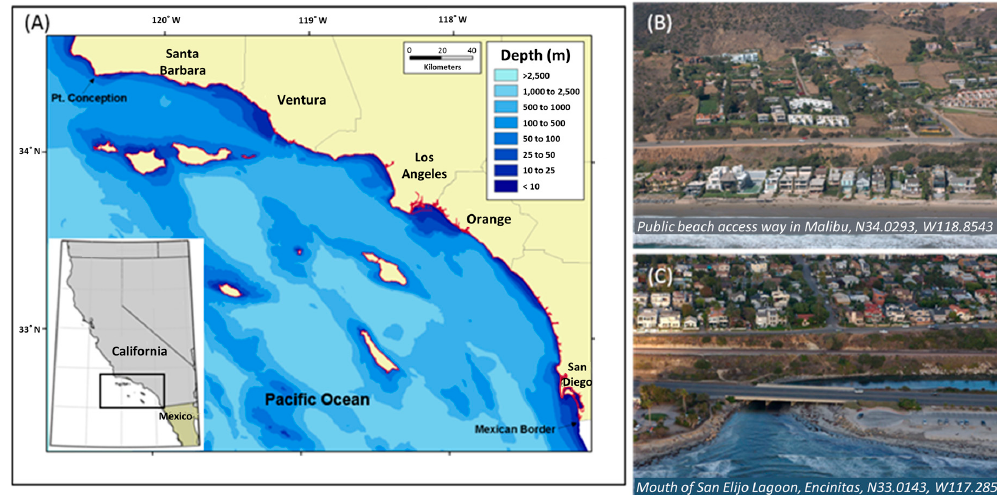
Figure 1. Overview of study area: ( A ) Southern California Bight and coastal counties; ( B ) aerial oblique photograph of Malibu; and ( C ) aerial oblique photograph of Encinitas. Both oblique photos highlight the urban infrastructure common throughout the study area. Image source: California Records Project, http://www.californiacoastline.org/. Tides are mixed, semi-diurnal, with a mean diurnal range of 1.7 m [26]. Offshore significant wave height can reach ~8 m during the most extreme events [27], and therefore even with dissipation across the shelf, wave-driven water levels (i.e., set-up and runup) are still the dominant contributors to extreme coastal water levels across the region, contributing as much as 3 m to the total water level, while storm surge and El-Niño-driven water level anomalies rarely contribute more than ~20–30 cm each [28,29].